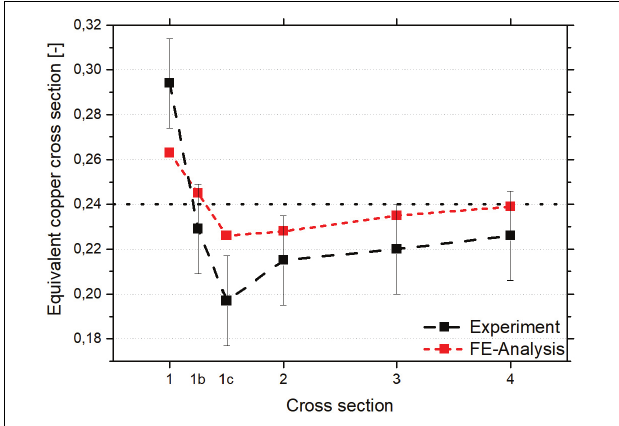
FIGURE 10 | Comparison of experimental and simulated copper cross